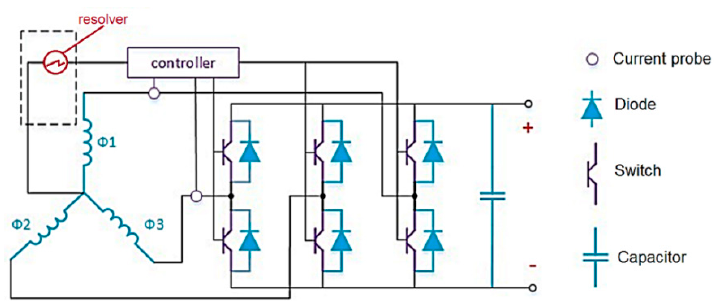
Figure 4. PMSM Power Control Unit diagram.